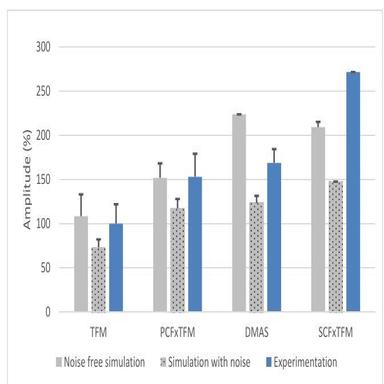
Comparison of the maximum amplitude for TFM, VCFxTFM, DMAS and SCFxTFM in the case of simulation with and without noise, as well as experiments. Values are normalized from TFM experimental results.